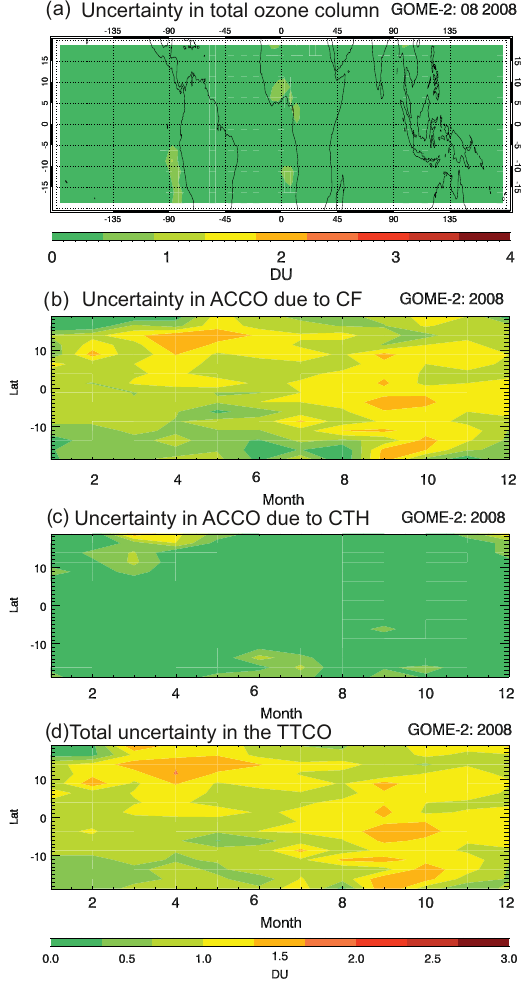
Figure 6. (a) The uncertainty in the WFDOAS TCO retrieval in Au- gust 2008 using SCIAMACHY (b) the uncertainty in the monthly averaged zonal ACCO due to CF for 2008 using SCIAMACHY data (c) the uncertainty in the monthly averaged zonal ACCO due to CTH for 2008 using SCIAMACHY data (d) the total uncertainty in the TTCO using the CCD method and SCIAMACHY WFDOAS total ozone data in 2008.